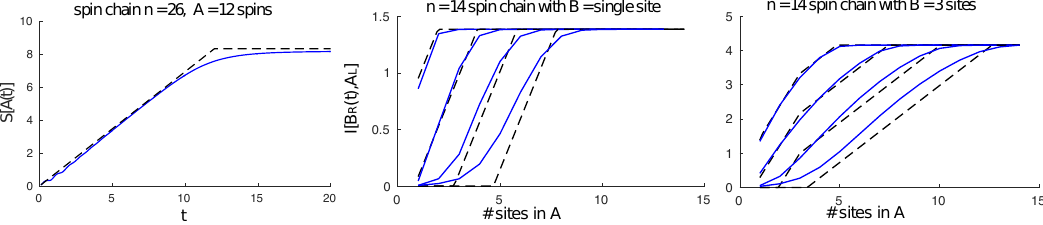
Figure 6 . Left: we plot S [ A ( t )] for the spin chain with initial state j Y + i and n = 26 spins. The region A consists of the (cid:12)rst 12 spins. We (cid:12)nd v E = 1 : 0. Middle, right: we plot I [ A ( t ) ; B R ] for the spin chain along with the lower bounds with v LC = 1 : 85 (see appendix A) and v E = 1 : 2 (which is the best (cid:12)t for the maximally entangled state). The di(cid:11)erent curves correspond to di(cid:11)erent times t , increasing from left to